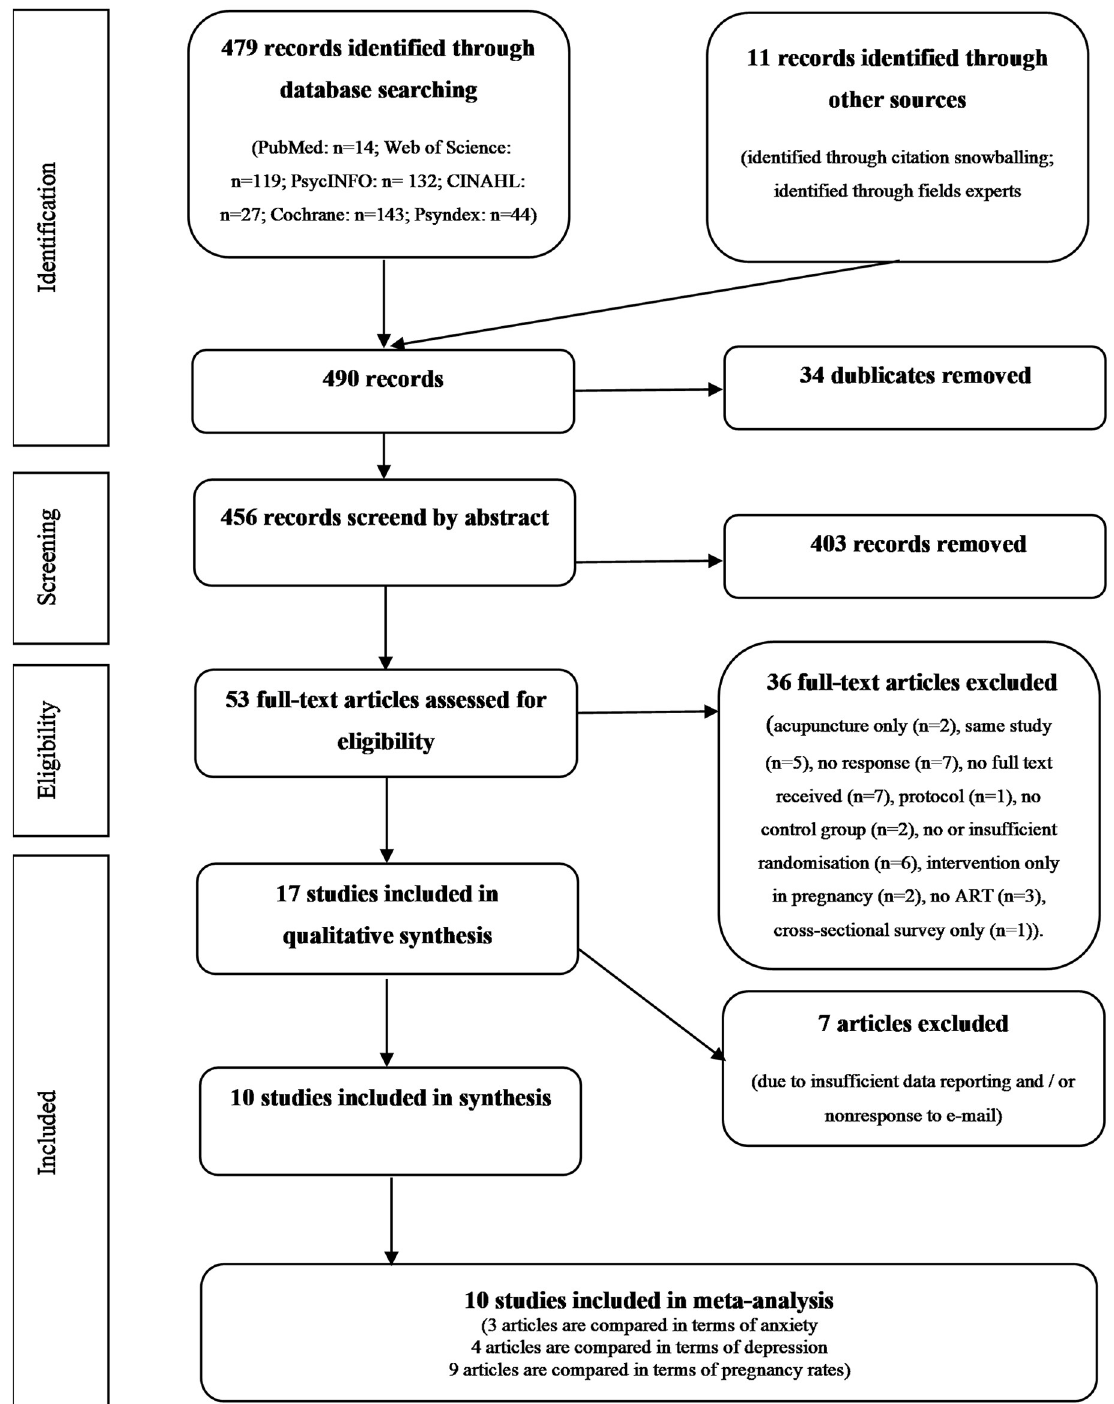
Fig 1. Prisma flow chart. Diagram showing the flow of information through the different phases of the systematic review and meta- analysis.